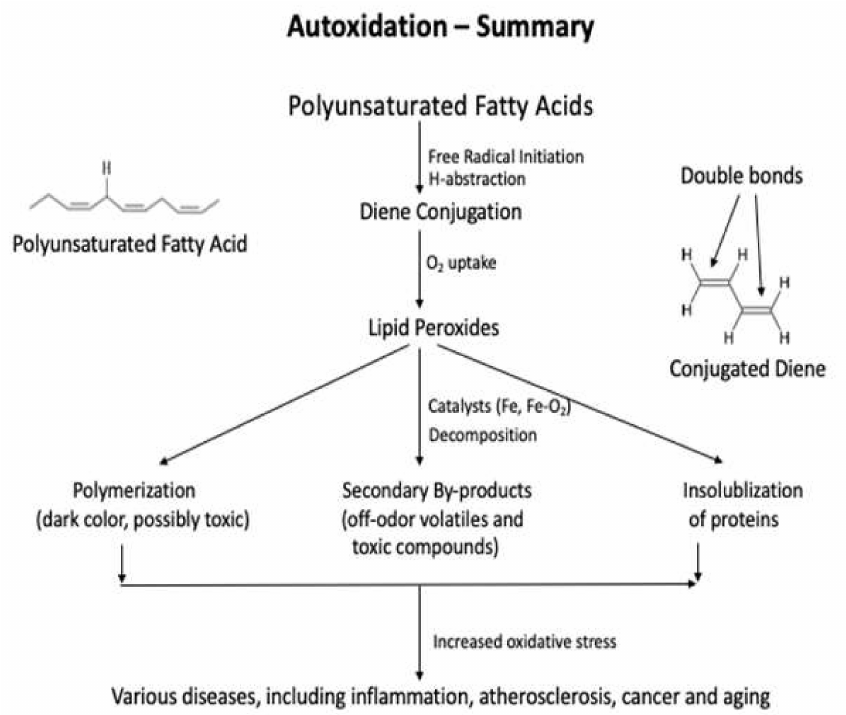
Figure 1. A schematic diagram of lipid oxidation pathway and the types of products produced. Lipid oxidation depends on many external and internal factors. Fatty acid profile, lipid class, and fatty acid composition are the main internal factors that affect lipid